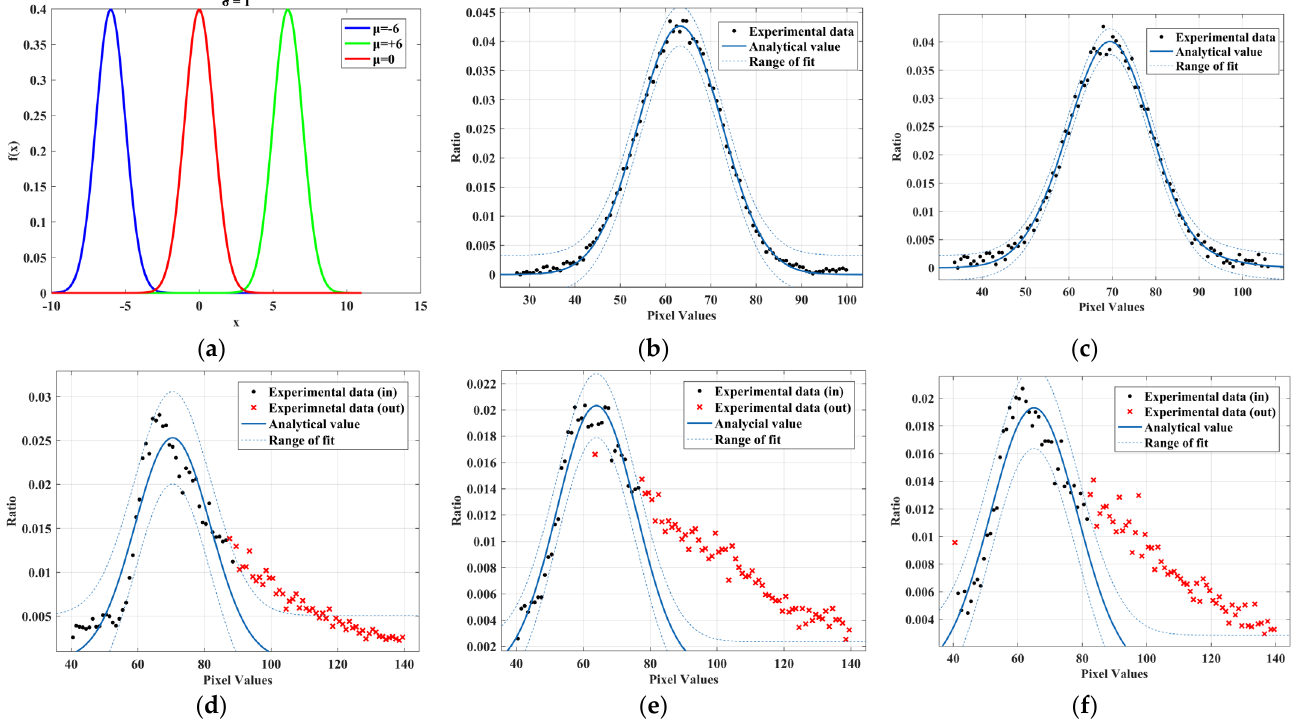
Figure 3. Noise amplitude fitting of a one-dimensional single Gaussian curve under different accumulated doses: ( a ) Gaussian curve; ( b ) 50 Gy; ( c ) 100 Gy; ( d ) 300 Gy; ( e ) 500 Gy and ( f ) 1000 Gy. Table 1. Parameters of a one-dimensional single Gaussian fitting noise amplitude distribution.